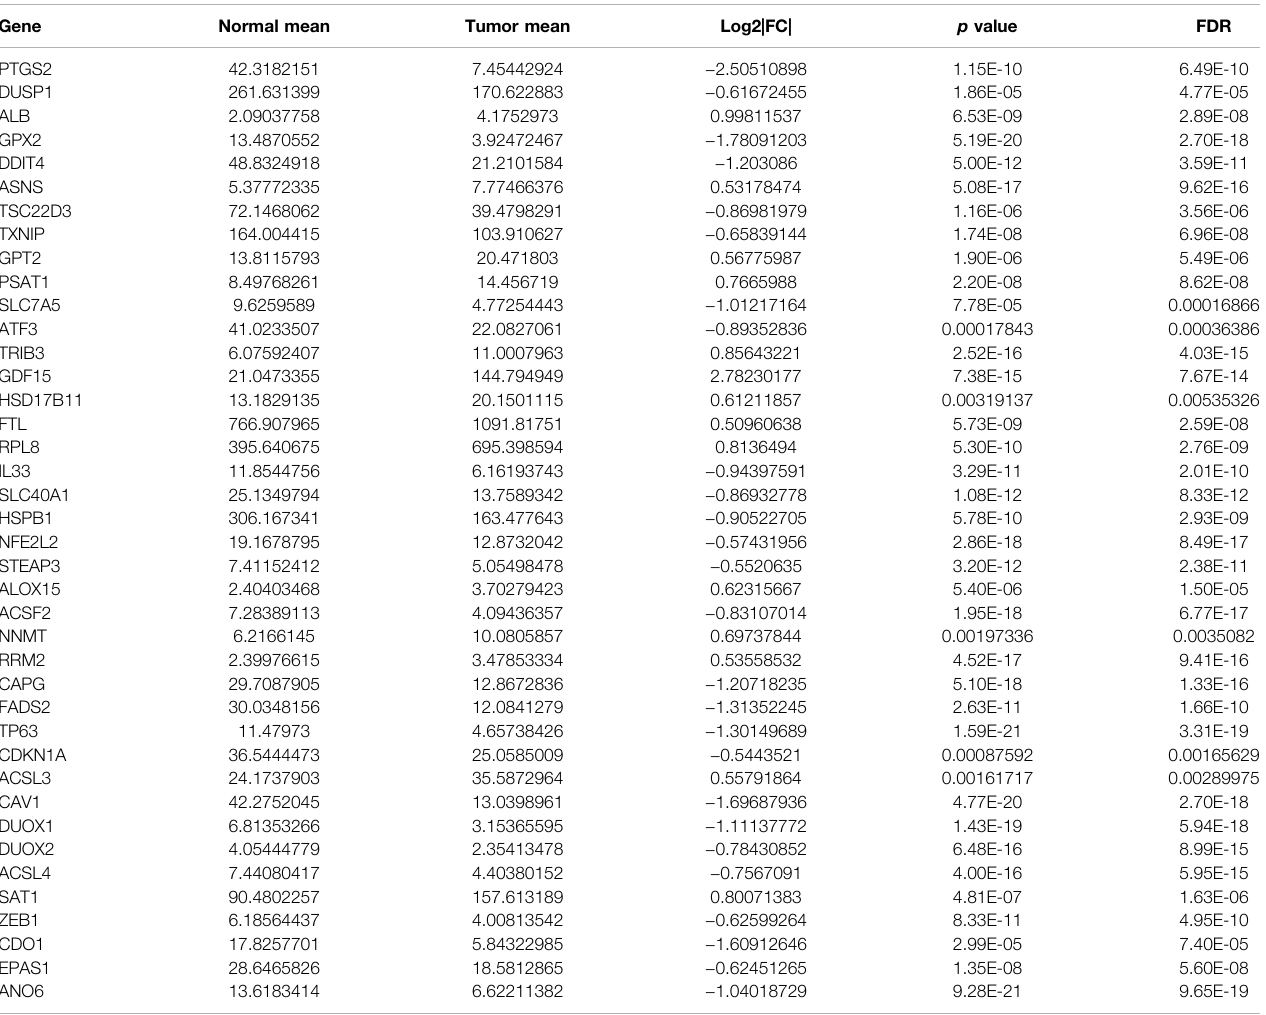
TABLE 2 | Identi fi cation of differentially expressed ferroptosis related genes. Gene Normal mean Tumor mean